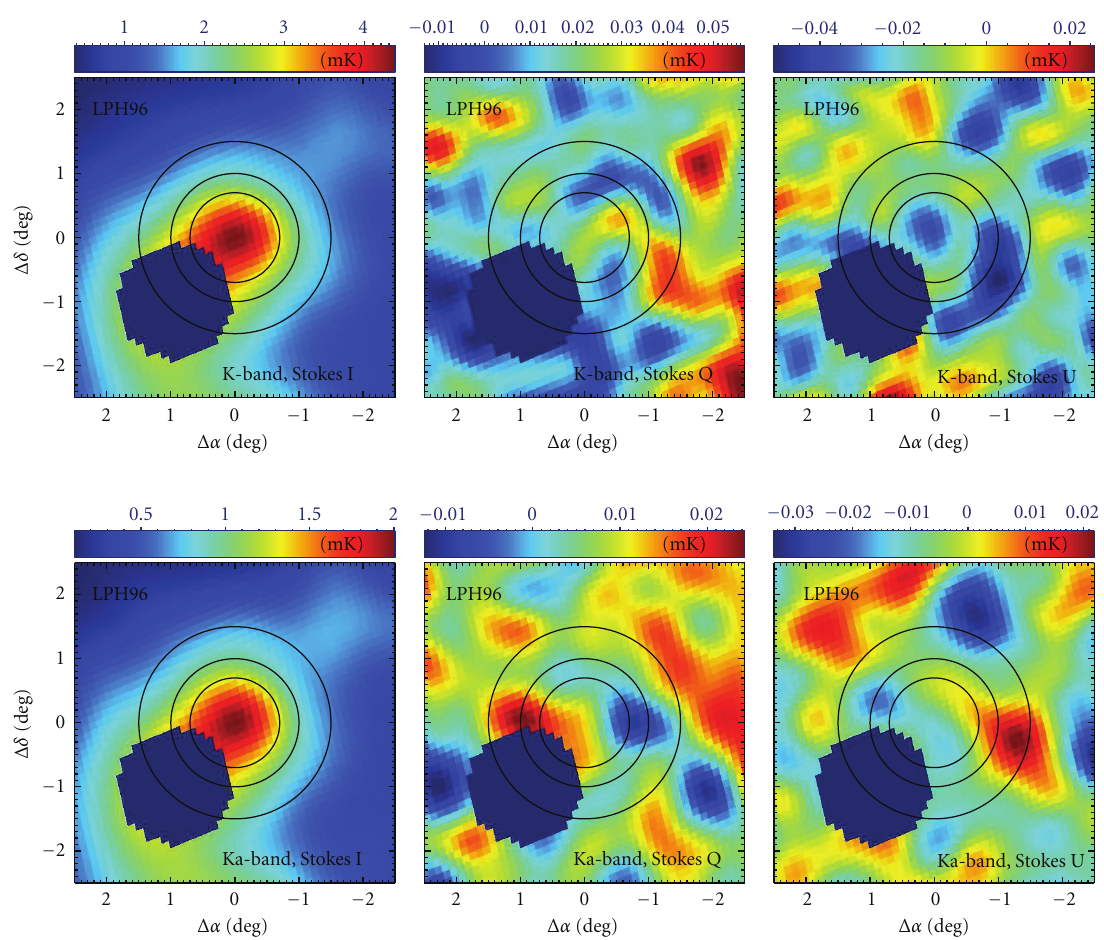
Figure 4: The same as Figure 3, but for the LPH96